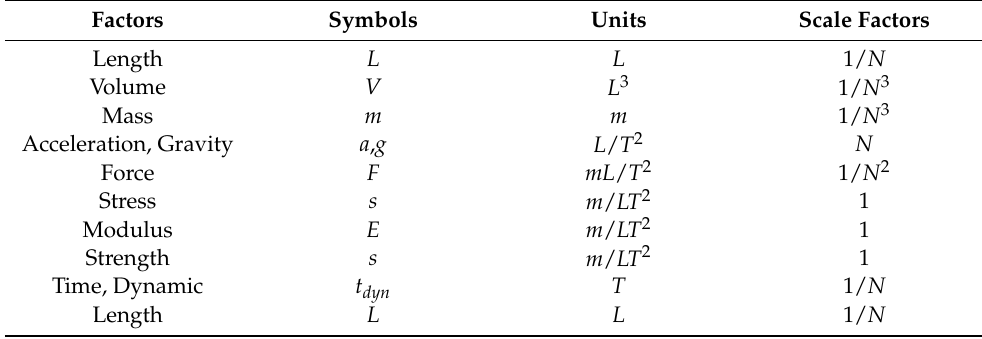
Table 1. Scaling lows of centrifuge model tests